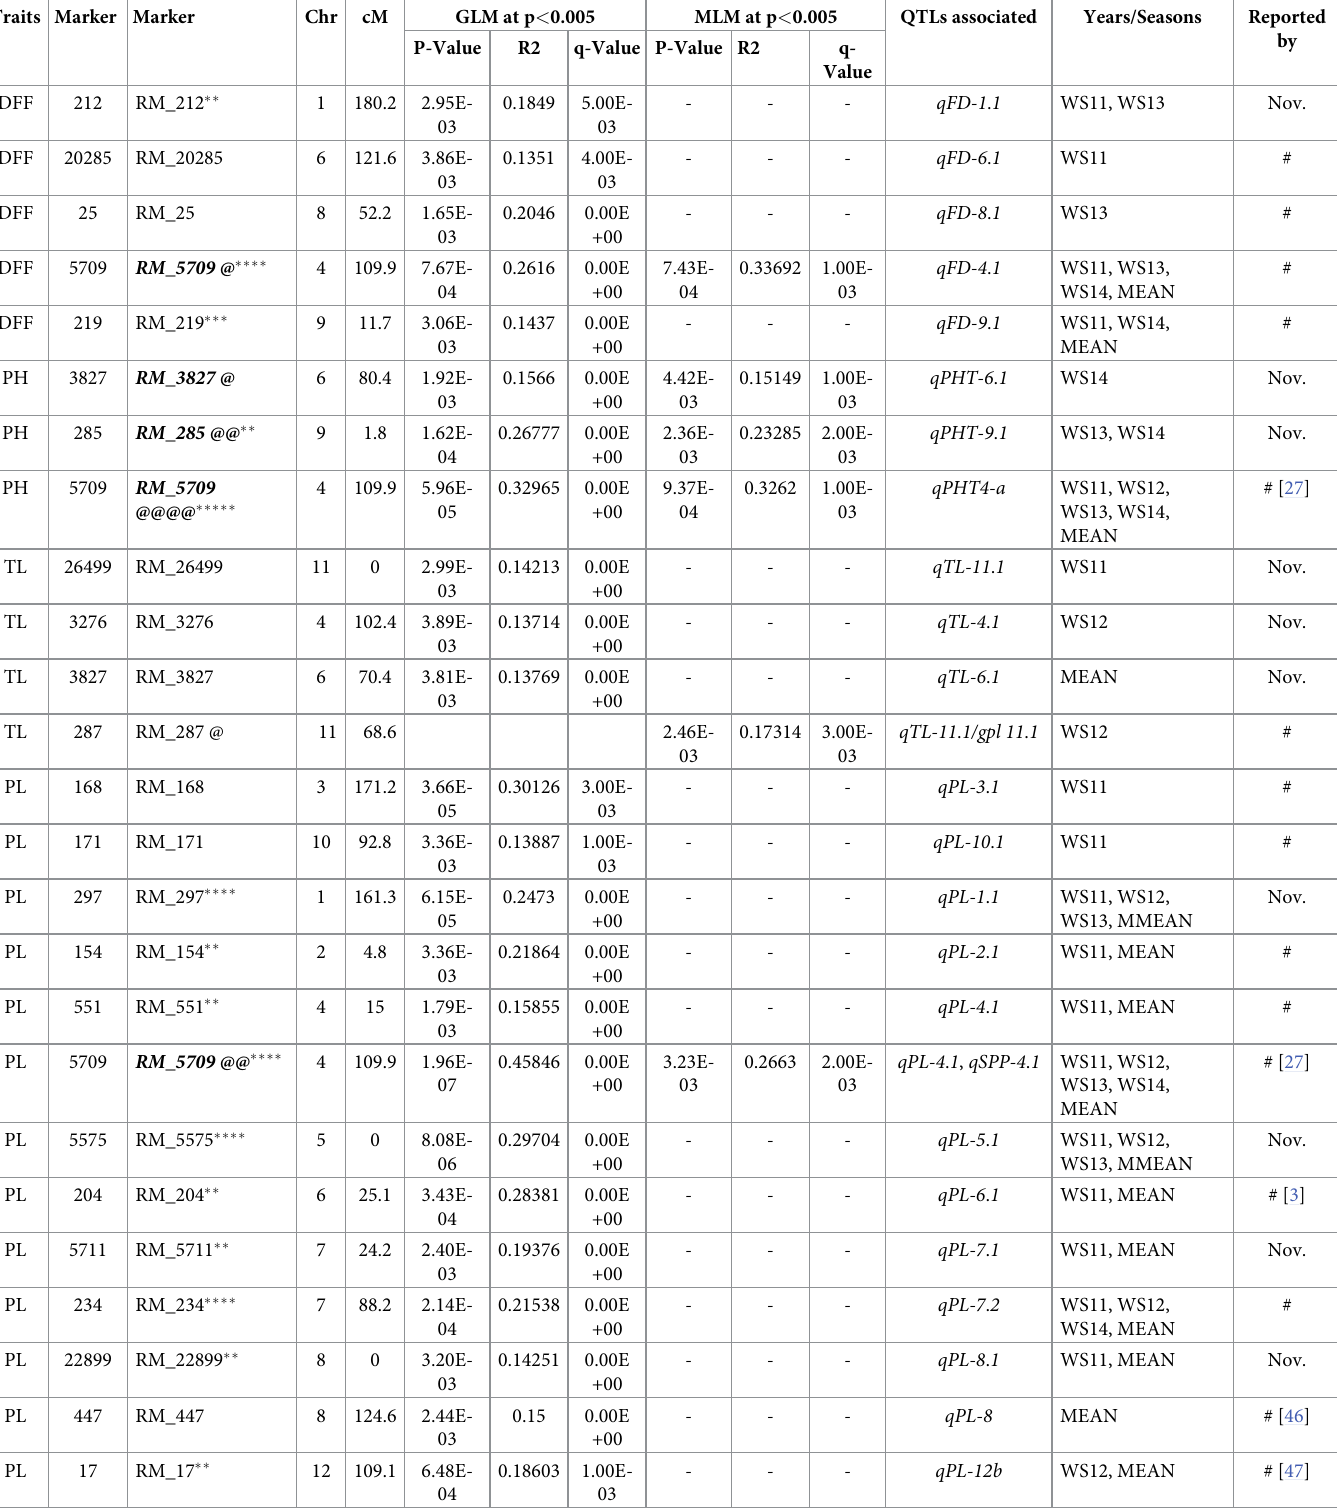
Table 5. Identification of SSR markers associated with grain yield and yield-related traits by using GLM and MLM models. Traits Marker